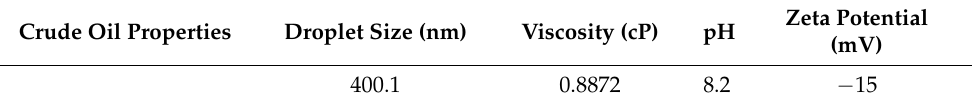
Table 2. Crude oil